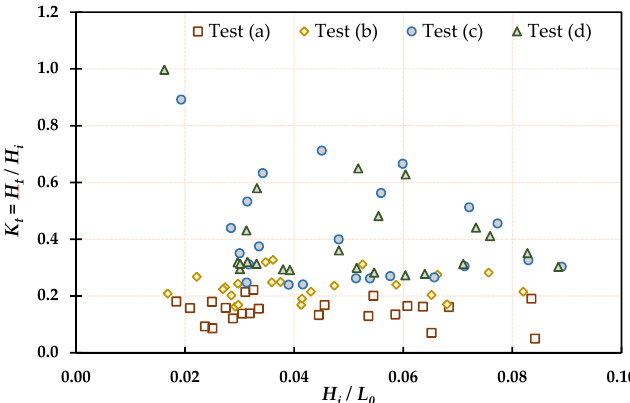
Figure 6. Effect of wave steepness ( 𝑆 (cid:3042)(cid:3043) ) on wave transmission ( 𝐾 (cid:3047) ). 3.1.3. Effect of Relative Wave Height ( 𝐻 (cid:3036) 𝐷 (cid:3041)(cid:2873)(cid:2868) ⁄ ) on Wave Transmission Coefficient ( 𝐾 (cid:2930) )